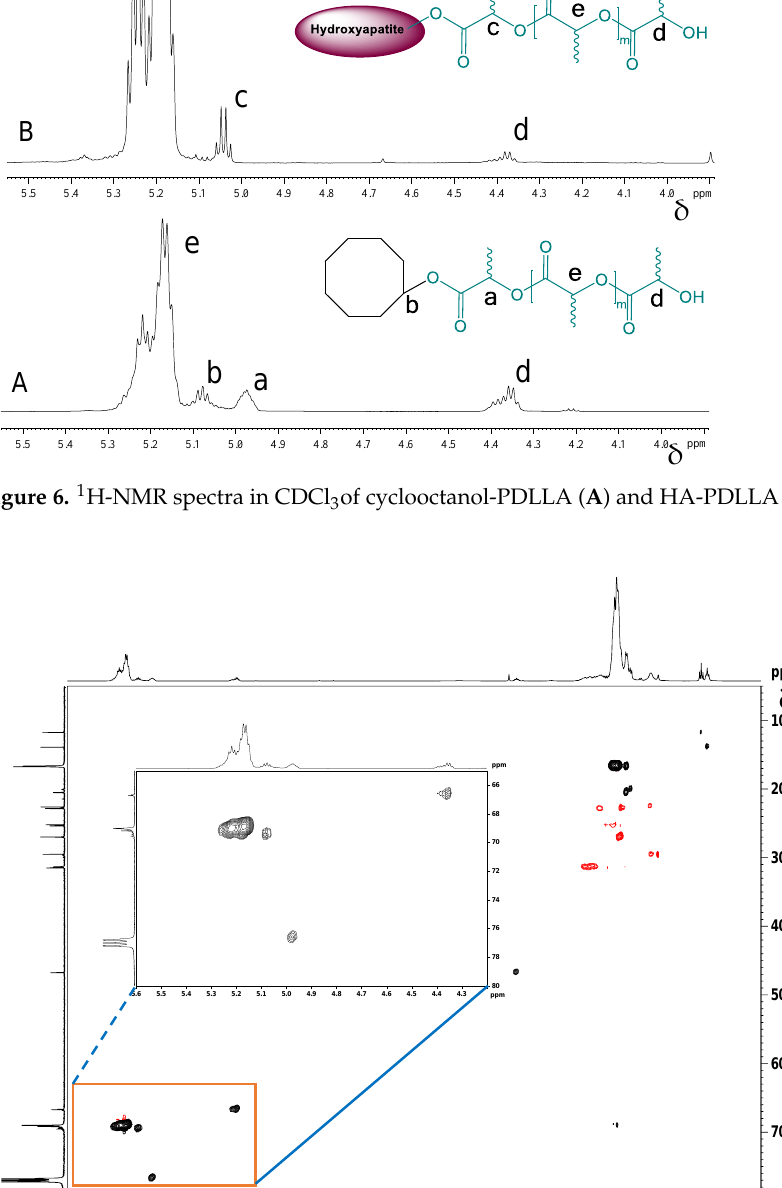
Figure 7. 1 H- 13 C Distortionless Enhancement of Polarization Transfer Heteronuclear Single Quantum Correlation (DEPT-HSQC) spectrum of the cyclooctanol-PDLLA homopolymer.